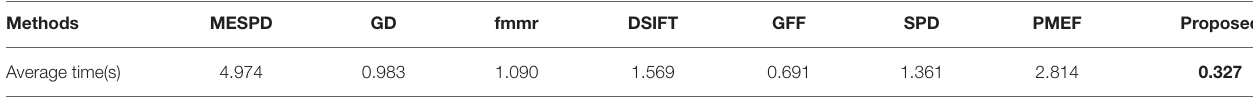
TABLE 4 | Comparison of image fusion efficiency of seven fusion methods. Methods MESPD GD fmmr DSIFT GFF SPD PMEF Proposed Average time(s) 4.974 0.983 1.090 1.569 0.691 1.361 2.814